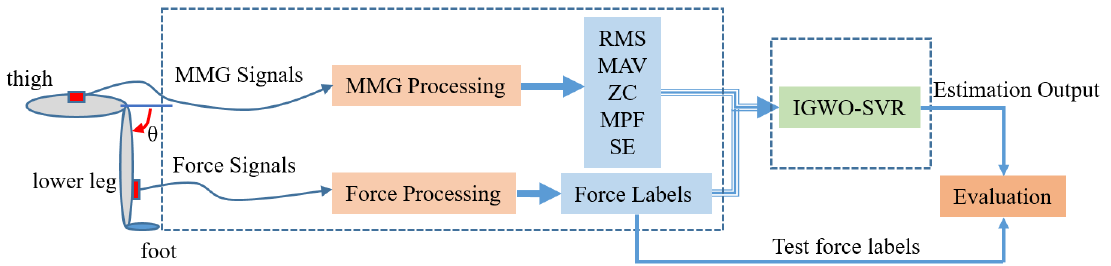
Figure 2. The specific process of knee joint extension force estimation based on IGWO-SVR and MMG .